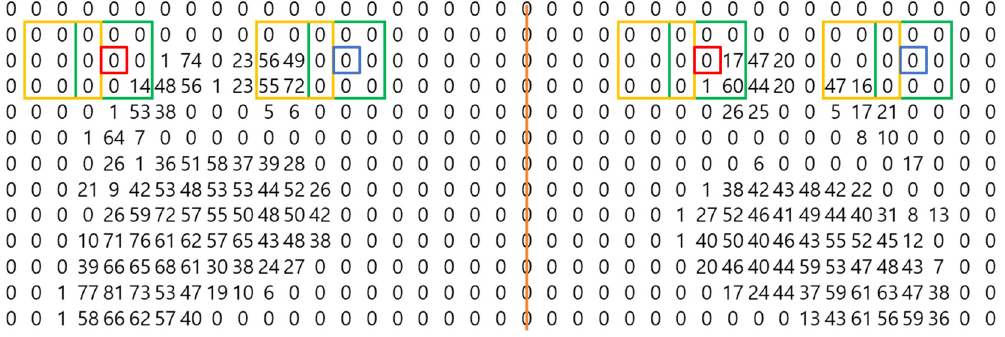
After separating foot-pressure data, foot classification takes advantage of the characteristics of the